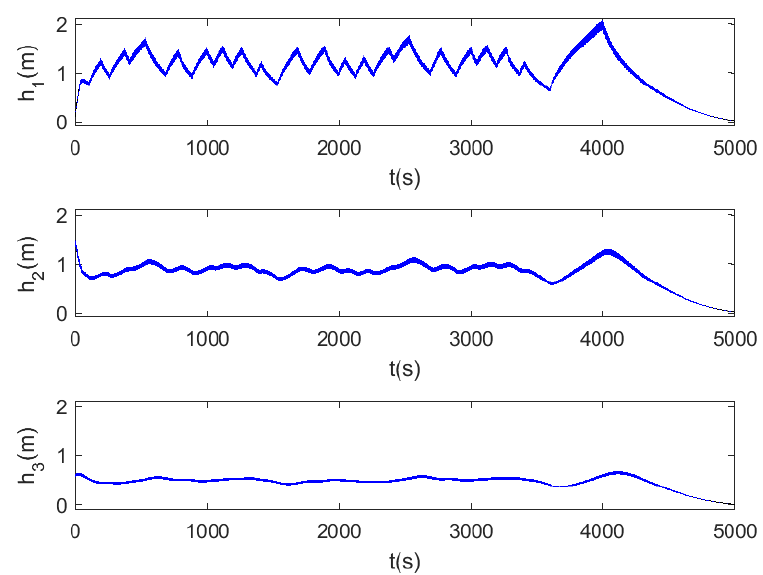
Figure 3. Three-tank system. Simulation results for the three state variables using real numbers. The dark bands are only apparent. They are the accumulation of the 1000 little vertical segments which represent the intervals associated to the resulting marks in the 1000 simulation points is contained in them and, thus, consistent with the model (17). 223 However, for t = 5000 s the results are 224